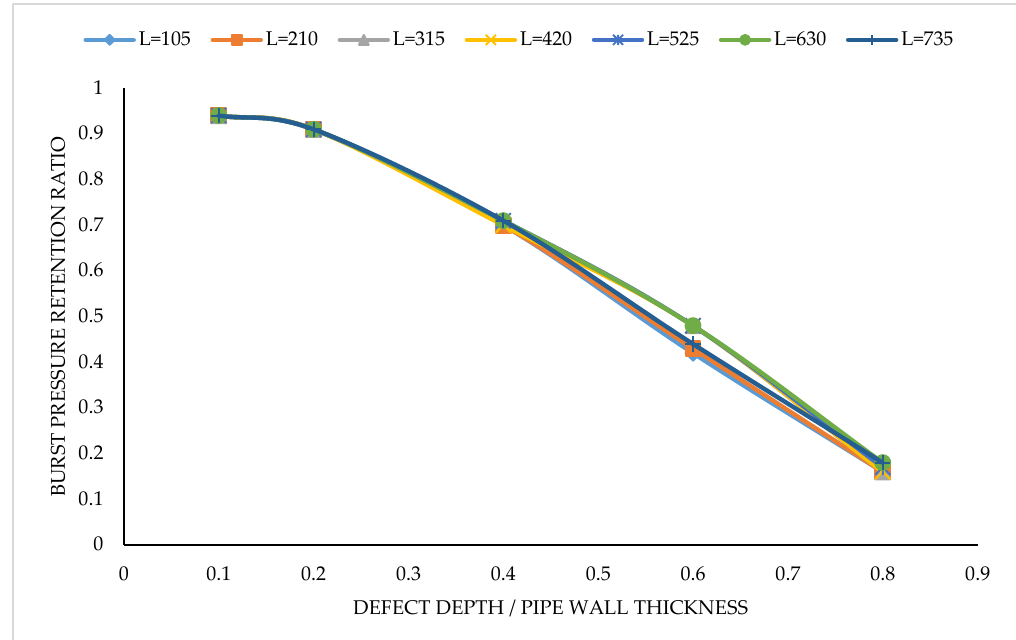
Figure 8. Variation of the burst pressure retention ratio with d/t for 323.6 mm diameter and 8.51 mm thick pipe for various corrosion defect lengths mm. Infrastructures 2017 , 2 , 15